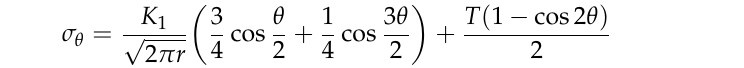
Figure 5. Specimens bent from the crack initiation point.